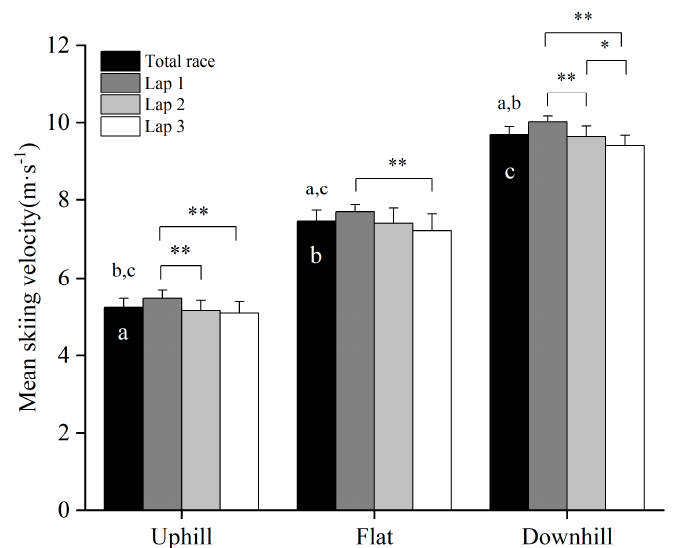
Figure 3. Average velocity in different terrains for each of the three laps and the entire 10 km skating time-trial competition in fourteen national-level male cross-country skiers. * Significant difference between laps ( p < 0.05); ** Significant difference between laps ( p < 0.01); a significantly different from uphill; b significantly different from flat; c significantly different from downhill (all, p < 0.05).